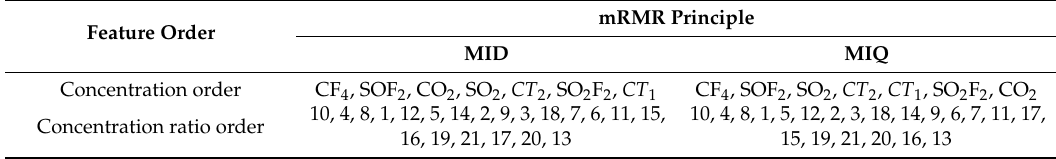
Table 4. Feature order based on mRMR principle.